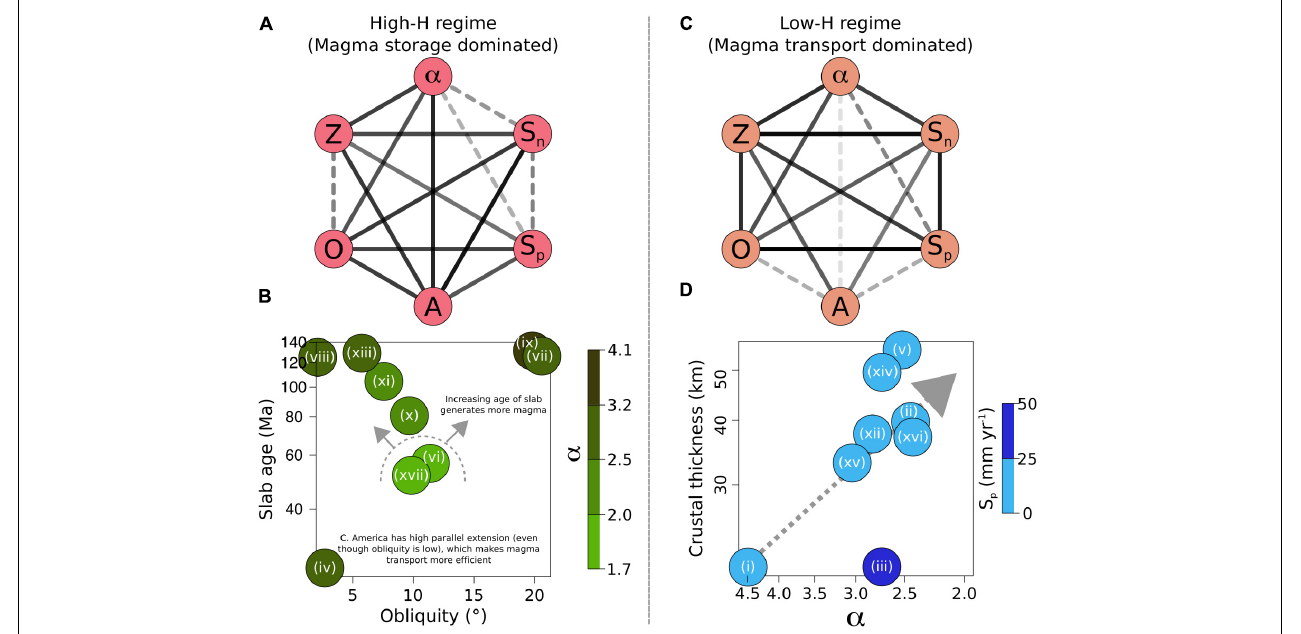
FIGURE 9 | The dominant parameters for the two regimes defined in Eq. 2. The colors of the nodes in the graphical models (a+c) relate to the colors of the two groups in Figure 8 and descriptions of each parameter can be found in Table 1 . (A) A graphical model for the high-H regime, signifying the importance of the slab age (A) and obliquity of convergence (O) on α . This is explored in (B) where an increase in the age of the slab (A) is correlated with an increase in α . C. America (iv) has a lower value of α because of the dominant extensional arc-parallel stress regime, discussed more in the main text. (C) A graphical model for the low-H regime, signifying the importance of crustal thickness on α . This is observed in (D) with a positive correlation between crustal thickness and decreasing values of α , except for the C. Aleutians (iii), which has high rates of subduction parallel to the volcanic arc. Arcs are labeled as follows: (i) Antilles, (ii) Cascades, (iii) C. Aleutians, (iv) C. America, (v) C. Andes, (vi) E. Aleutians, (vii) Hokkaido-Kuriles, (viii) Honshu, (ix) Izu-Bonin, (x) Java-Bali, (xi) Kamchatka-Kuriles, (xii) Mexico, (xiii) NE. Japan, (xiv) N. Andes (xv) Ryuku, (xvi) S. Andes, and (xvii) W. Alaska.